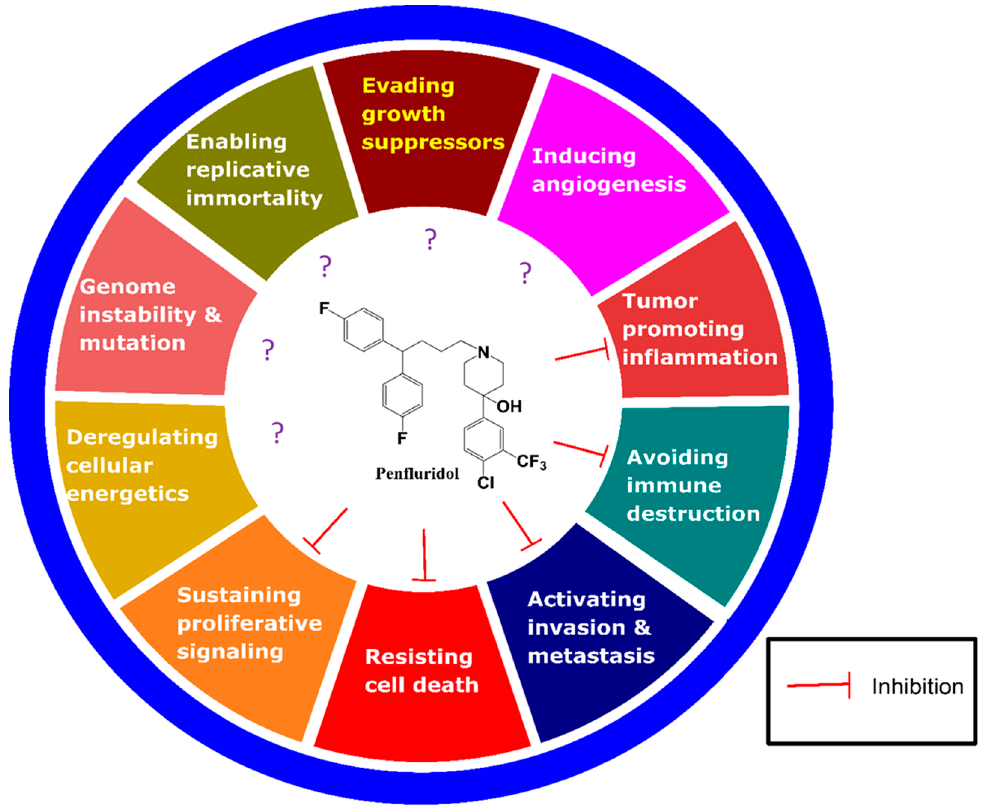
Figure 2. The hallmark of cancer. Inhibition mark ( ㅏ ) indicates the part inhibited by penfluridol and question mark (?) indicates the part not yet studied. Modified from Hanahan & Weinberg’s report